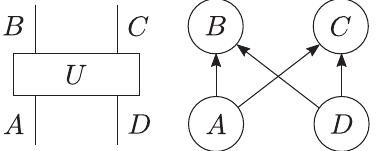
FIG. 7. For a generic unitary transformation from AD to BC , the complete common cause of B and C is the composite system AD